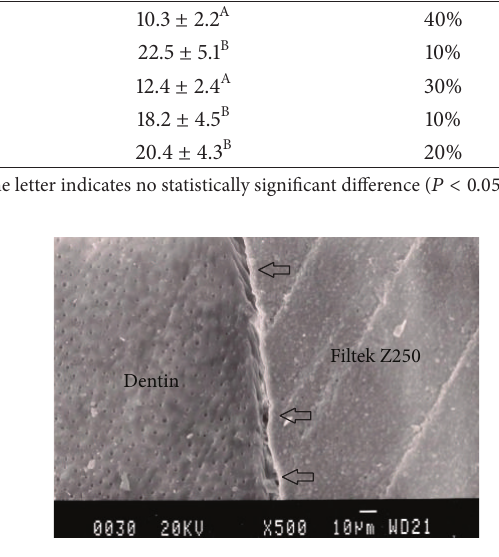
Figure 1: Representative SEM photomicrograph of a Group 1 spec- imen (Filtek Z250, 55 ∘ C). The arrows indicate microgap formation between Filtek Z250 and